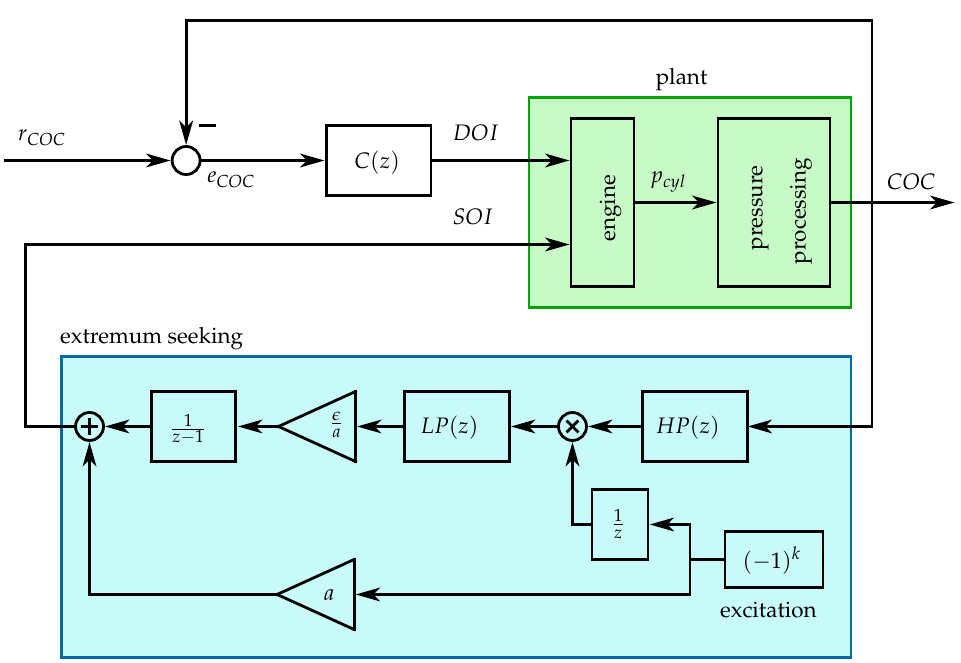
Figure 9. Diesel-minimal combustion control structure of the fast excitation approach: fast excitation on the start of injection SOI . The center of combustion COC is fed to the extremum seeking controller. The time shift 1/ z is added to the extremum seeking controller in order to assign the output COC to the corresponding input SOI . The center of combustion COC at the time step k is a function of the inputs at the time step k − 1 (see Equation